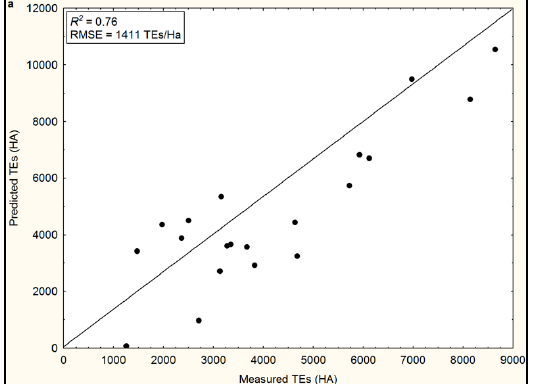
Figure 5. (a) Performance of the PLS models in predicting TE on the independent test dataset